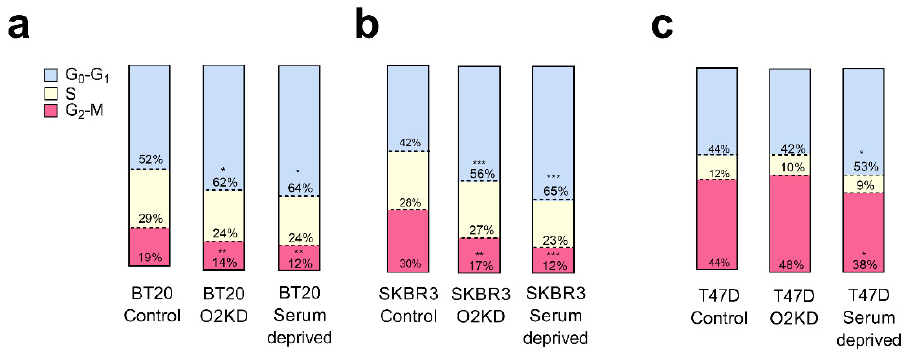
Figure 6. Orai2 is required for cell cycle progression. ( a , c ) BT20 ( a ), SKBR3 ( b ) and T47D ( c ) cells were transfected with esiOrai2 (O2KD) or non-specific siRNA (Control), as indicated, or were serum deprived. Forty-eight hours later, cell cycle analysis through PI staining and following flow cytometry was performed as described in Section 4. Stacked bars are representative of three independent experiments. Data were statistically analyzed using Kruskal–Wallis test with multiple comparisons (Dunn´s test) to cells transfected with non-specific siRNA (* p < 0.05, ** p < 0.01 and *** p < 0.001).